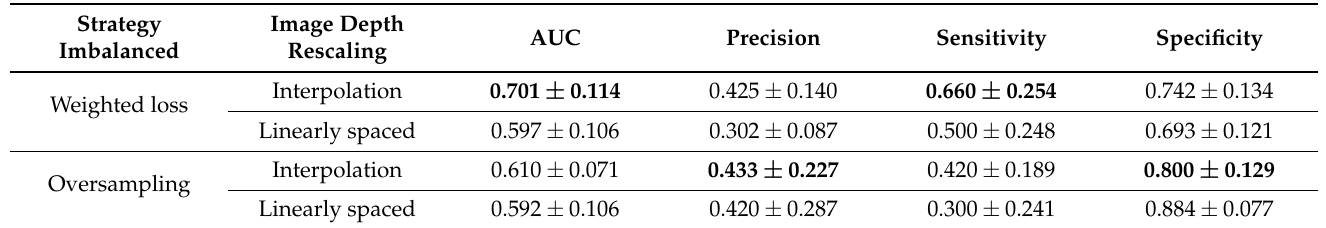
Table 6. Performance results for the EGFR mutation prediction when considering different strategies to handle imbalanced data. The evaluation metrics are presented as mean ± standard deviation averaged over 10 random train-test splits.